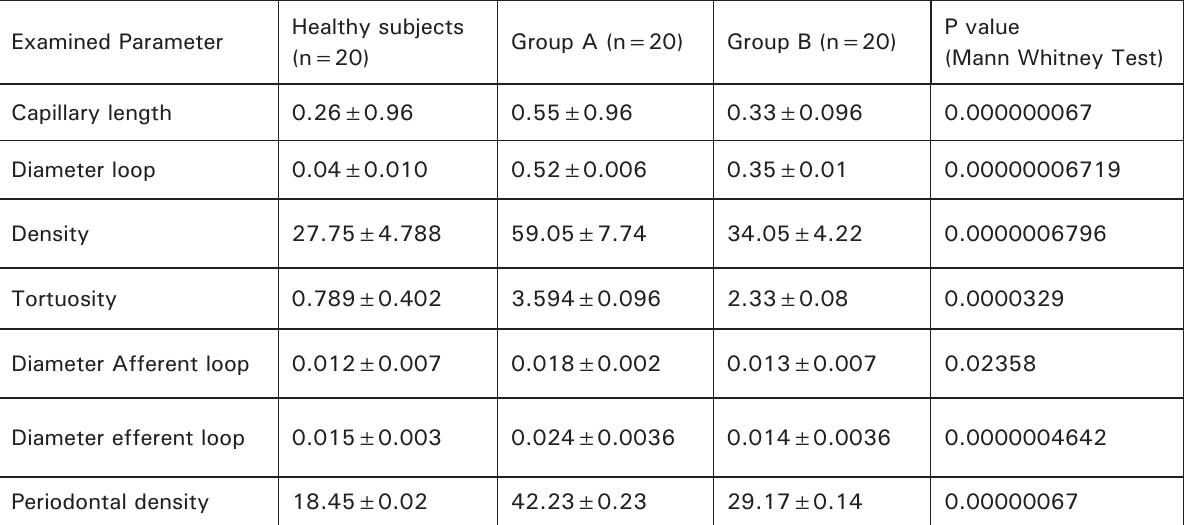
Table 1. Oral microvascular differences in patients affected by hypertension in treatment with clonidine (group A) and metaprololol (group B)